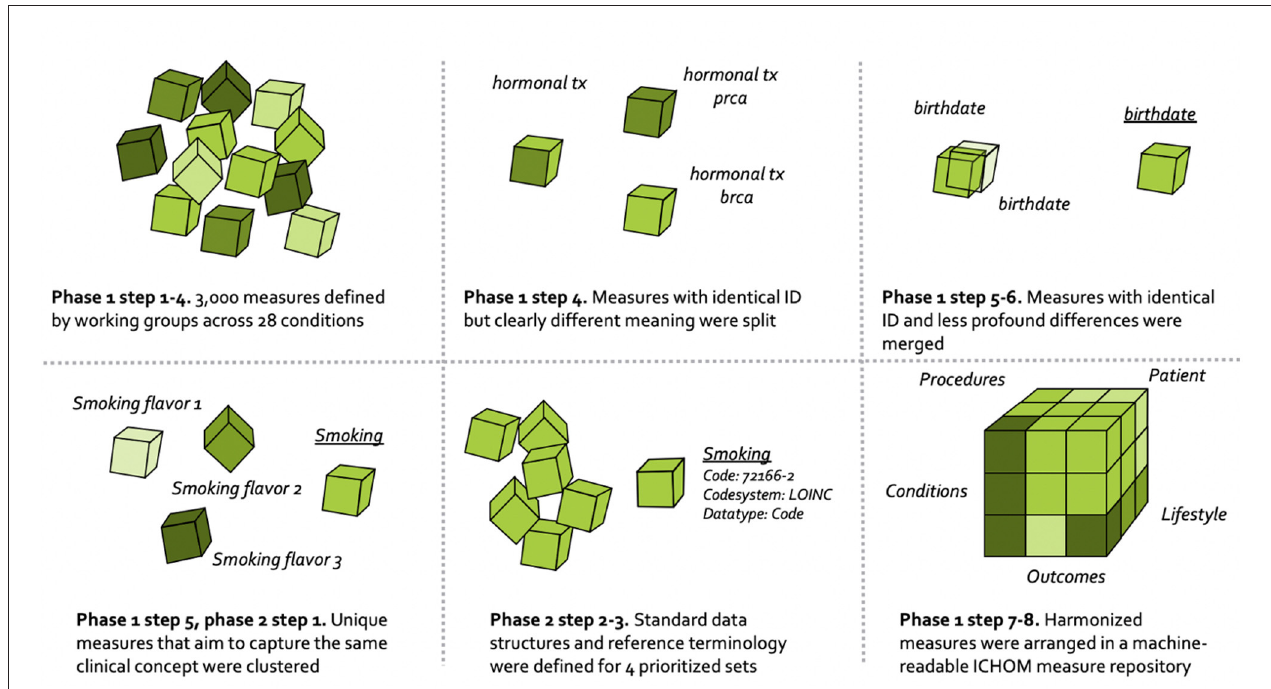
FIGURE 1 | Flow-diagram depicting process for harmonizing the ICHOM